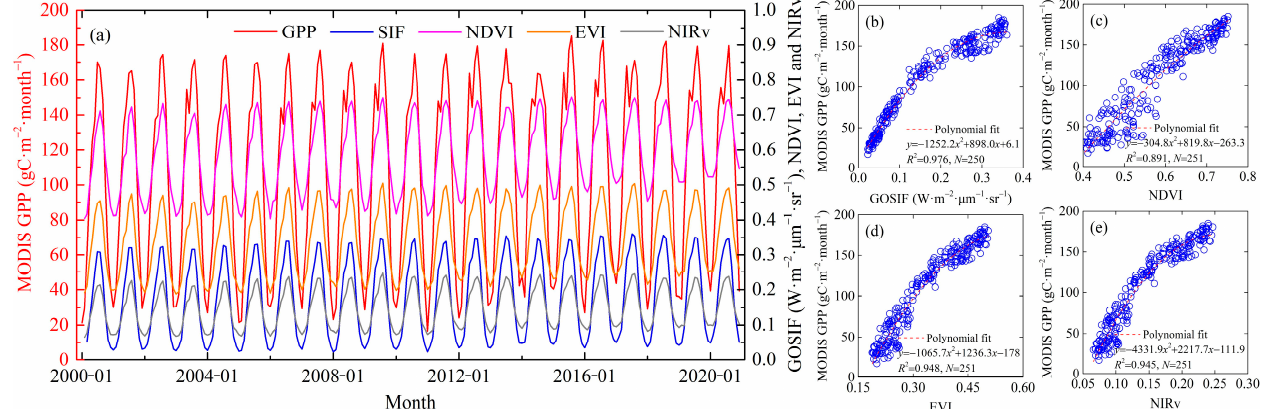
Figure 5. Temporal variations of monthly mean MODIS GPP and GOSIF, NDVI, EVI, NIRv ( a ) and their polynomial fit ( b – e ) during 2000–2020. Note: N indicates the data size.